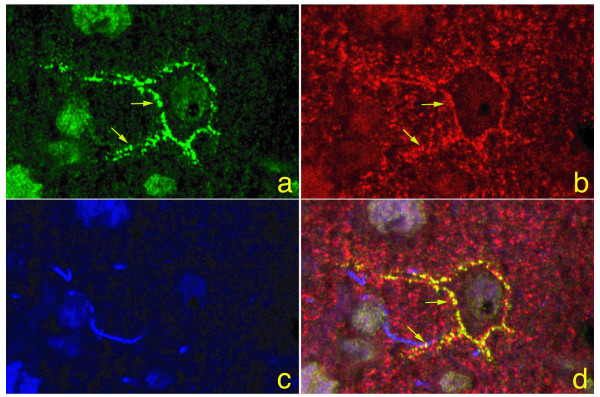
Synaptic localization of KChIP1 in a subset of parvalbulmin-positive GABAergic neurons presynaptically in vivo. a: Adult rat cortex was immunostained with a polyclonal antibody against KChIP1 (green), and b: a monoclonal antibody against synaptophysin (red), and c: a monoclonal antibody against GFAP (blue). Sections were examined under confocal microscopy. d: An overlay image shows colocalization (yellow) of KChIP1 and synaptophysin at the plasma membrane of neuronal cell bodies and processes. No GFAP-labeled cells were KChIP1 positive. Arrows indicate colocalization of KChIP1 and synaptophysin. Bar = 40 μm.